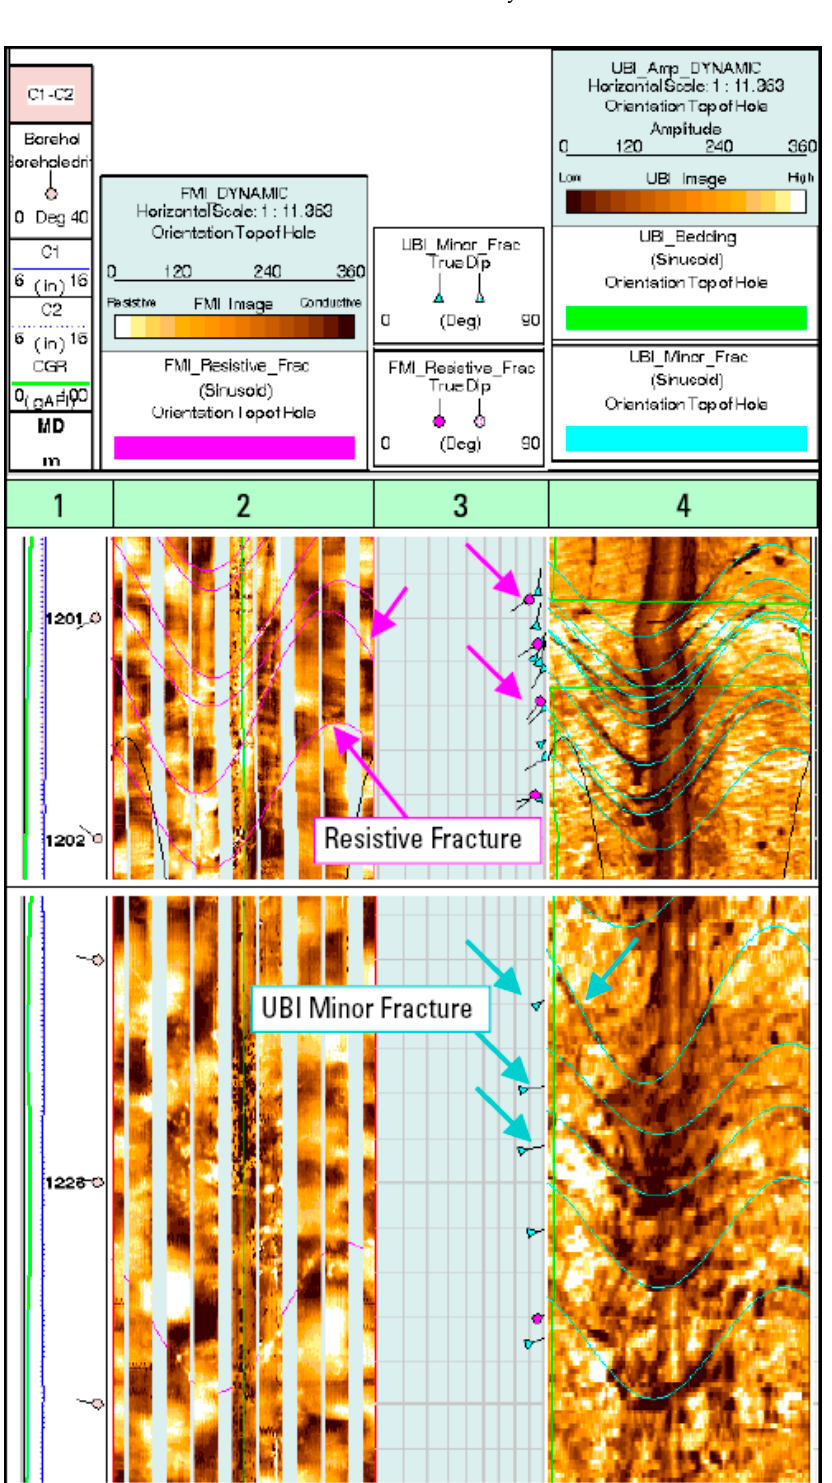
Resistive fractures on the FMI image are indicated by magenta arrows (Figure 10). Minor open fractures on the UBI image are shown with cyan arrows, below. In some cases, one feature appears on both images but open on the UBI image and closed on the FMI image. This may indicate that the open fractures are filled with oil-based mud, which is detected by the FMI tool as resistive fractures.